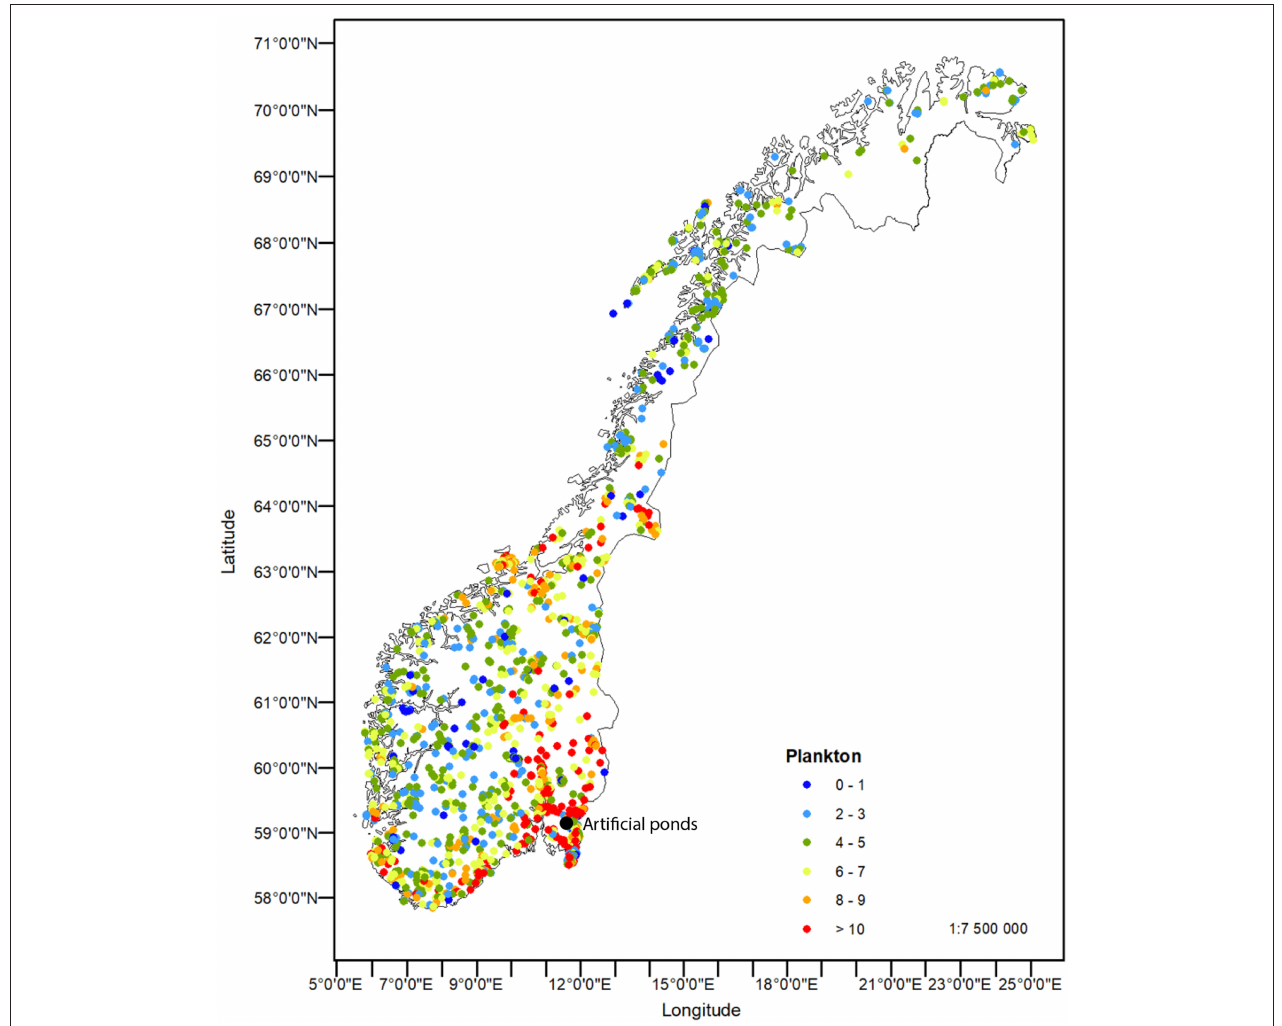
FIGURE 2 | Species richness of pelagic crustacean zooplankton across the Norwegian mainland. Color codes represents the number of species per locality. The site of the constructed, artificial ponds is